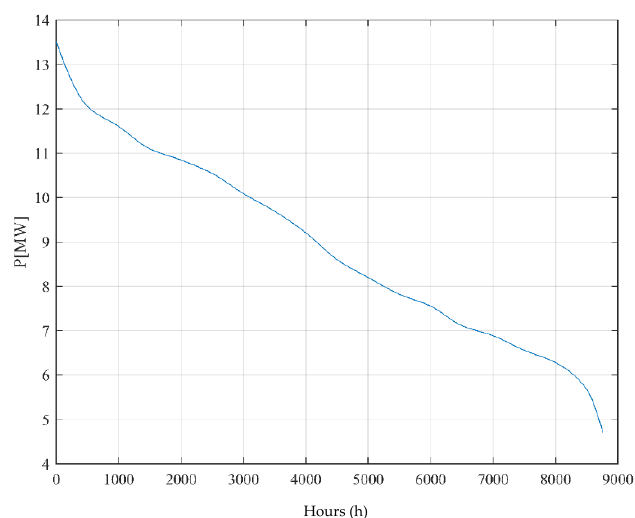
Figure 12. MV line case study tower layout. Energies 2019 , 12 , x FOR PEER REVIEW